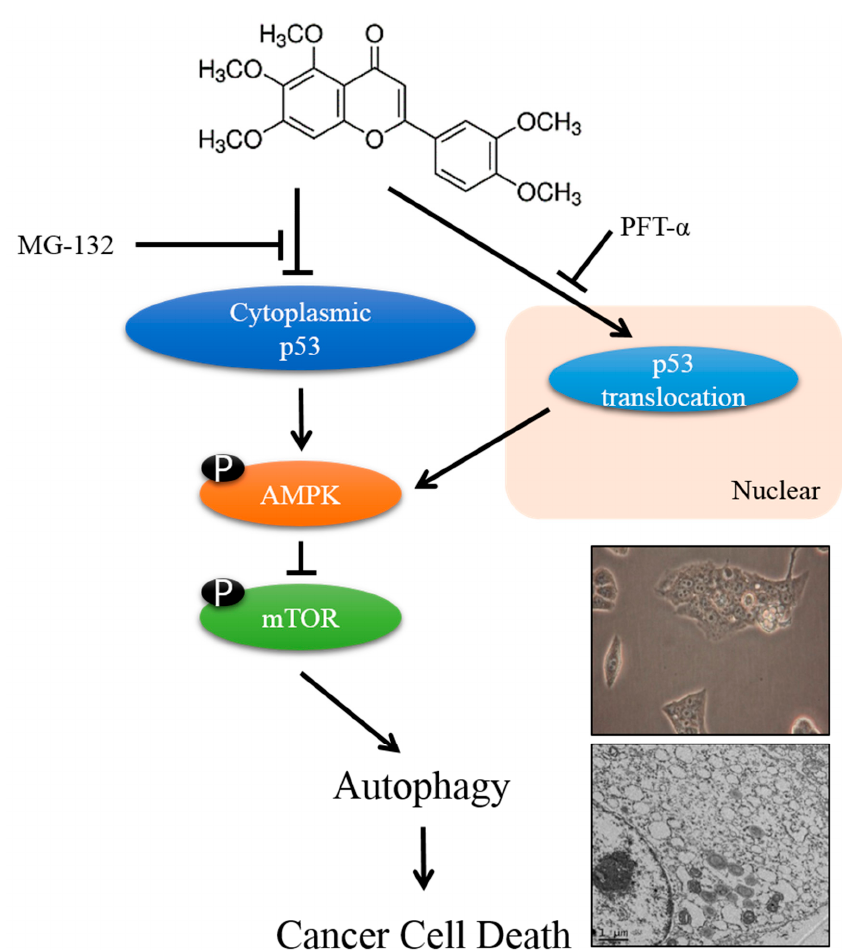
Figure 7. Schematic diagram characterizes the autophagic cell death mechanism of SIN in HepG2